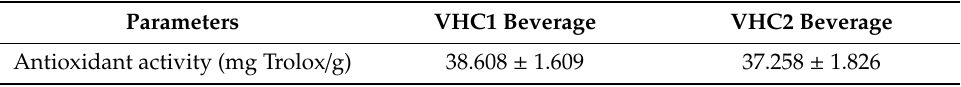
Table 4. Antioxidant activity (mg Trolox / g) of final products.